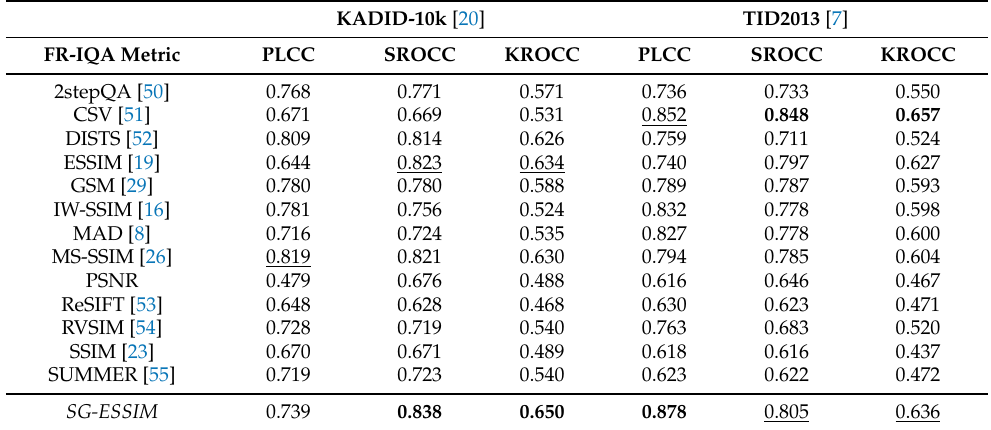
Table 3. Comparison of the SG-ESSIM to several other state-of-the-art algorithms on KADID-10k [20] and TID2013 [7]. The highest values are typed in bold , while the second highest ones are underlined.